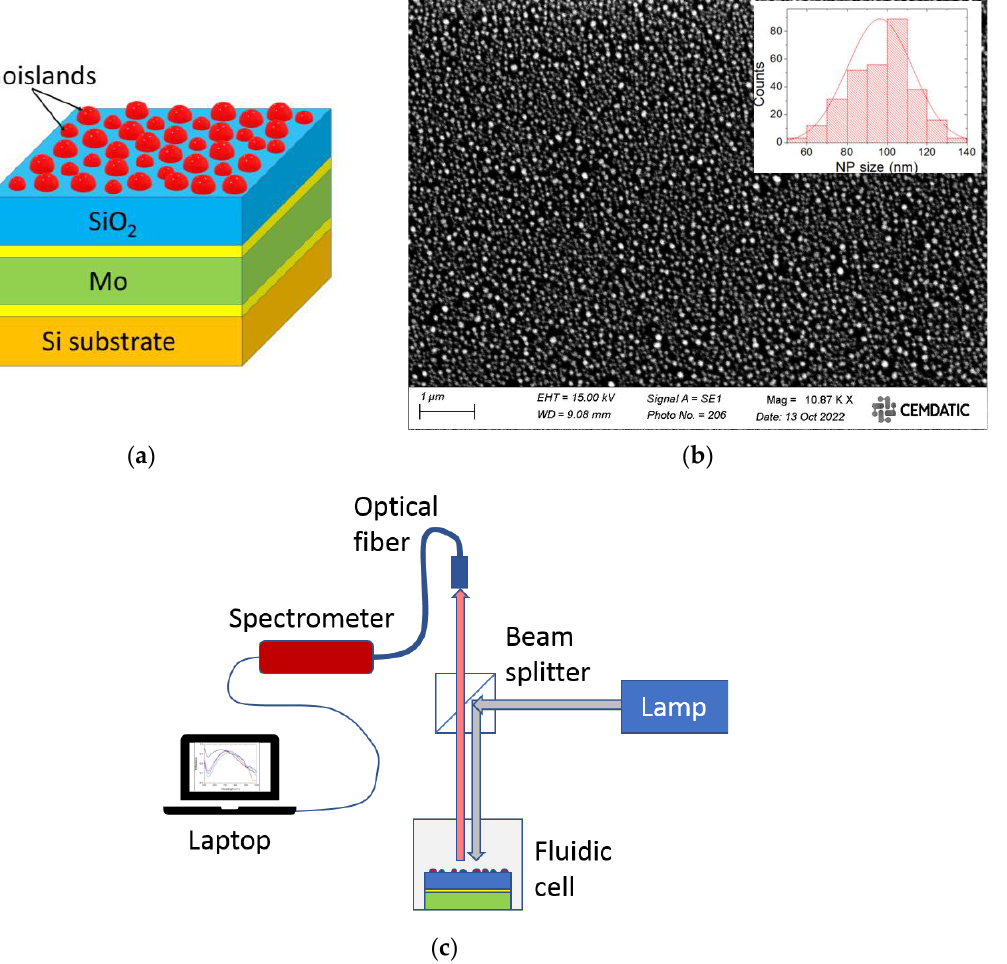
Figure 1. ( a ) Schematic view of the fabricated Au nanoisland/Fabry – Pérot cavity self-referenced refractive index sensor; ( b ) SEM top view of the fabricated device after thermal annealing revealing the formation of Au nanoislands (bright regions). Inset shows the size distribution histogram (bars) and normal function fit (line) of 300 Au NPs; ( c ) schematic diagram of the spectral reflectance measurement setup.